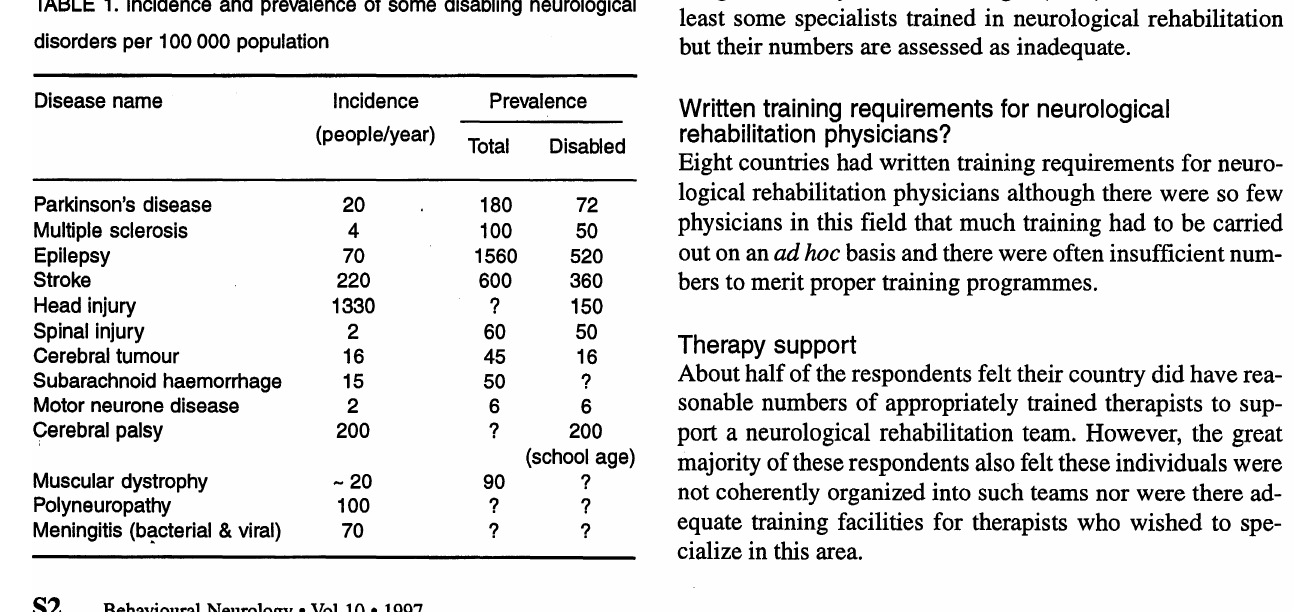
TABLE 1. Incidence and prevalence of some disabling